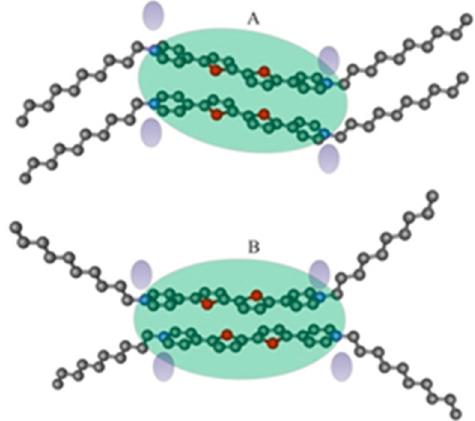
Figure 4. Low-energy models of dimer formed by thienoviologen salt units giving rise to a disc-like motif of elliptic shape (discoid). ( A ): face-to-face configuration where the planar cores have a parallel arrangement of the dipole moments associated with the thiophene rings. ( B ): translation of the planar cores parallel to the long axis and an anti-parallel arrangement of dipole moments associated with the thiophene rings. The counterions are indicated by the shadowed small ovals. The pendant decyl chains are drawn as pointing in the same direction in the zig-zag model A and in opposite directions in B, as an example. In general, they are in a disordered conformation. The intercore distance is 0.4 nm in A and 0.37 nm in B.